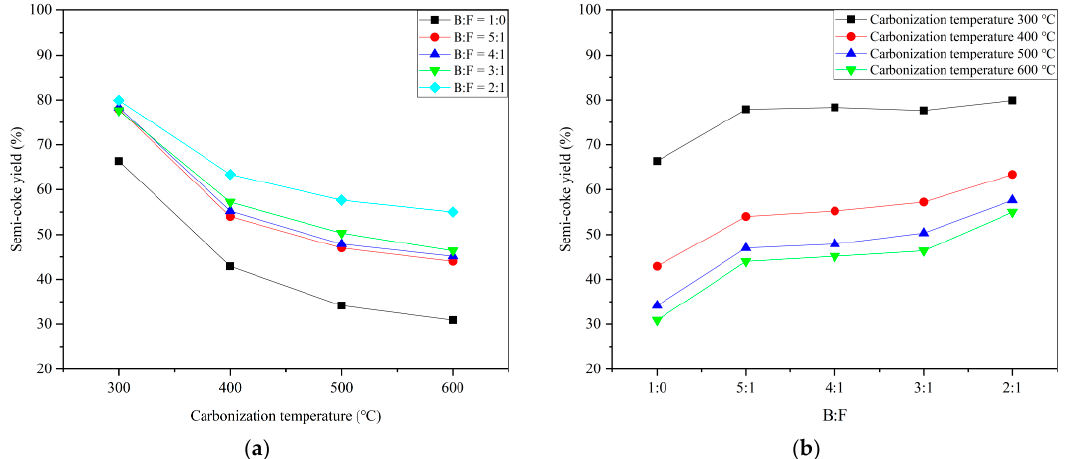
Figure 2. Variation trend of the yield of semi-coke with respect to the carbonization temperature and mixing ratio of raw materials: ( a ) different carbonization temperatures and ( b ) different mixing ratios of raw materials.